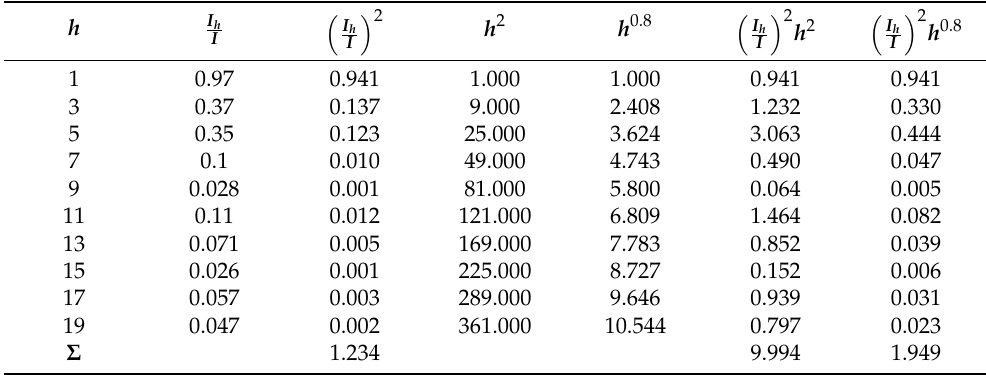
Table 8. Computation of the harmonic loss factor (IEEE Std.